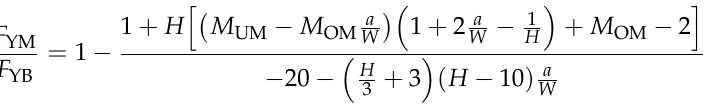
Figure 5. Formation of the yield zone in a heterogeneous weld with a crack in the over-matched part of the weld for varying weld width H and constant crack length a / W = 0.5.